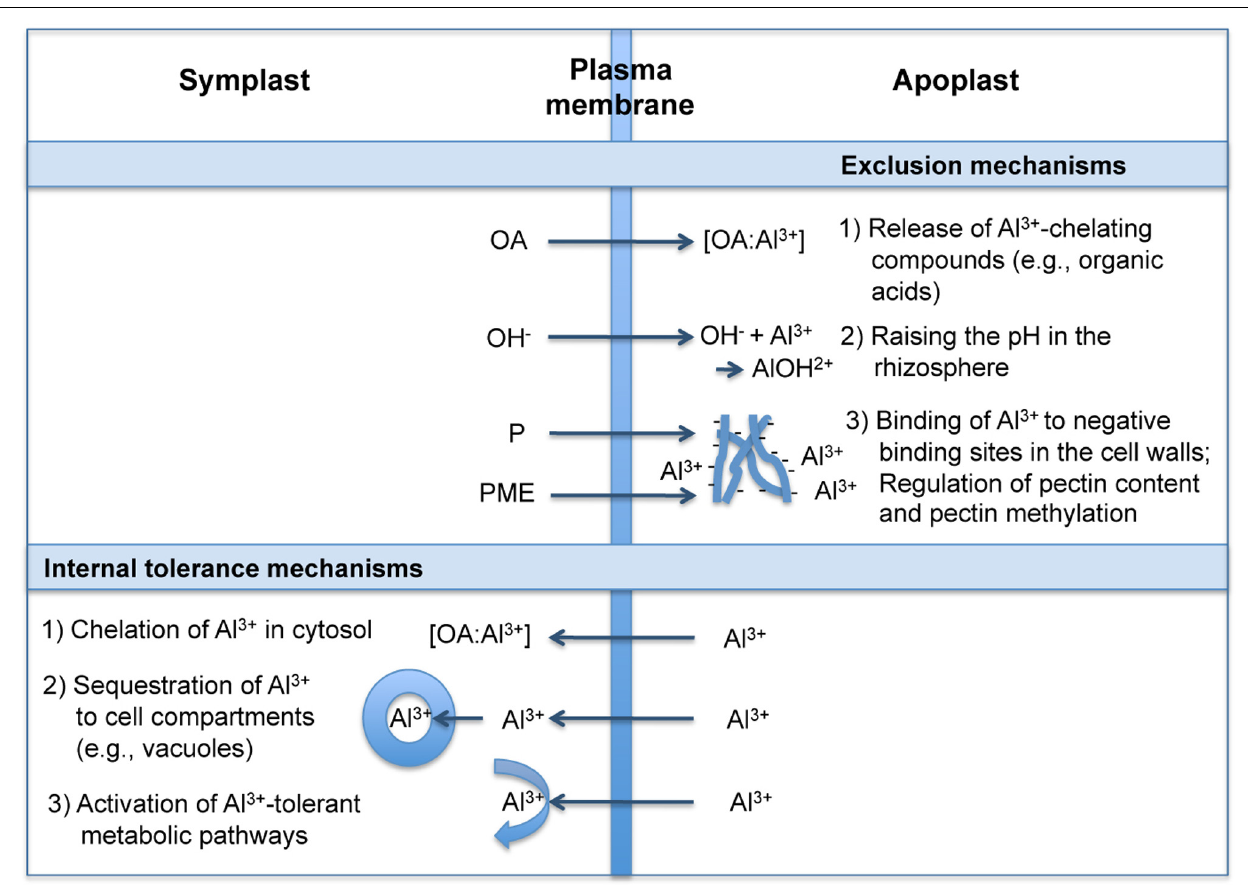
FIGURE 2 | Mechanisms of plant roots to deal withAl 3 + (modified from Jones and Ryan, 2003; Inostroza-Blancheteau etal., 2012). OA, organic acids; P, pectin; PME, pectin methylesterase.